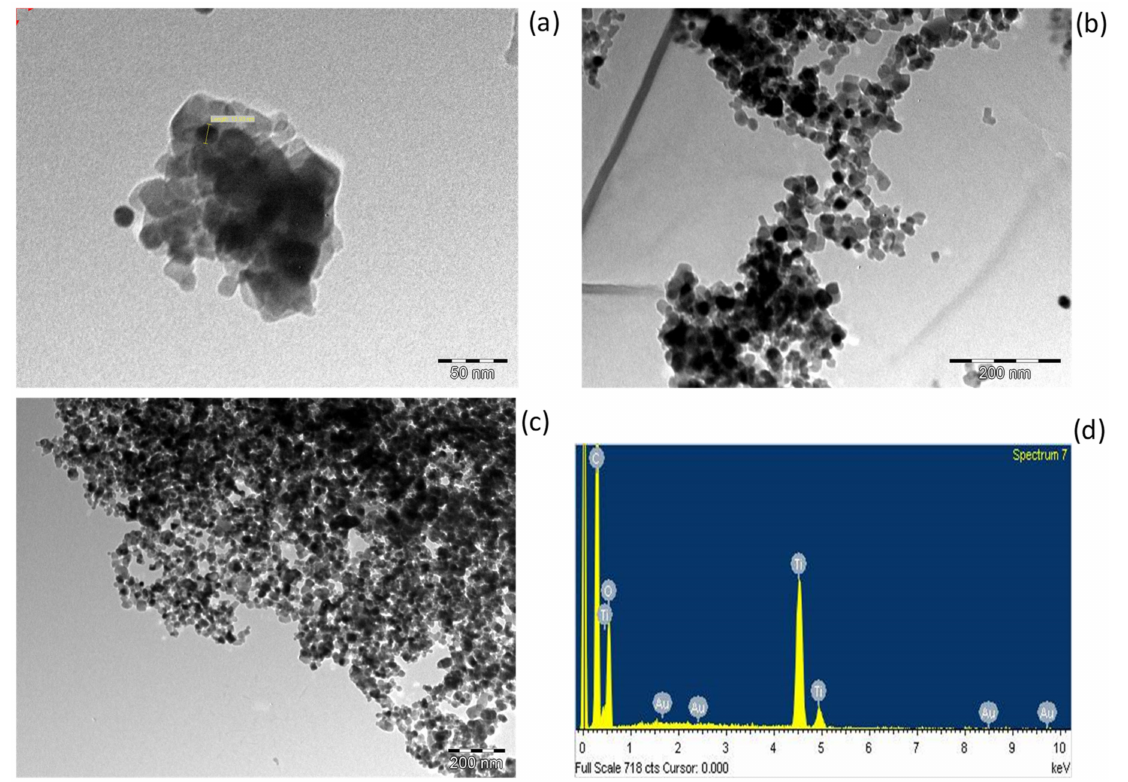
Figure 8. TEM image of Au/TiO 2 nanocomposite with gold nanoparticles’ TEM sizes of ( a ) 14, ( b ) 30 and ( c ) 40 manometers with their ( d ) EDX